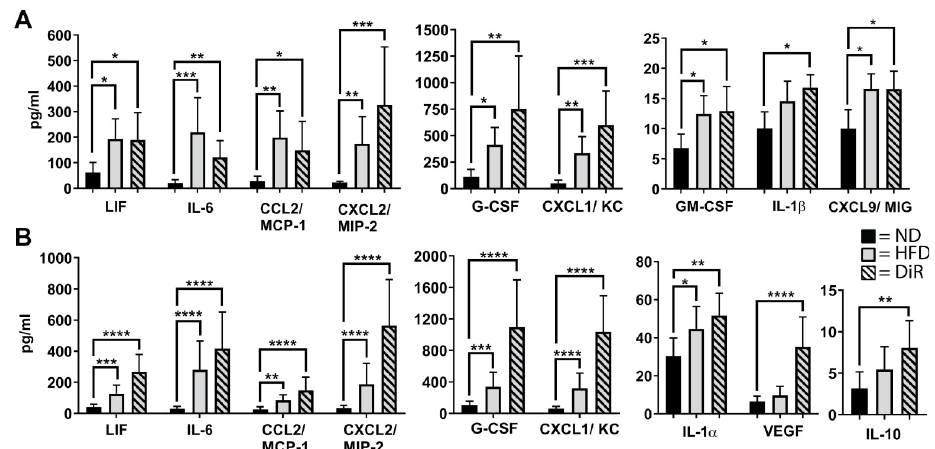
Fig 3. Inflammatory protein expression in corneas. C57BL/6 male mice were fed the ND or HFD for 10 weeks, and diet reversal (DiR) mice were fed the HFD for 5 weeks followed by the ND for 5 weeks. Corneas (n = 6 per group) were excised and cultured for 6h in vitro , and the (A) corneal extracts and (B) culture supernatant were analyzed for chemokines, cytokines and growth factors. Data shown as means ± SD. � p < 0.05, �� p < 0.01, ��� p < 0.001, ���� p < 0.0001.